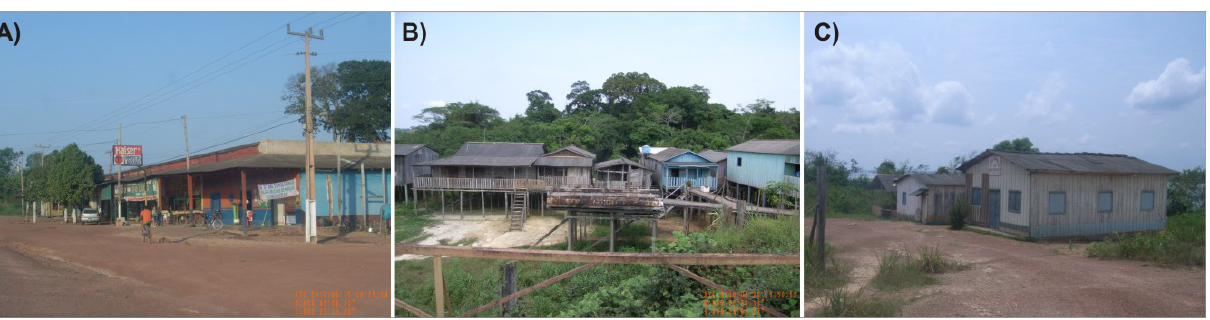
Figure 8. Spatial patterns verified within the units of human occupation categorized as Dependent on connectivity : ( A ) Taboca; ( B ) Aruri; ( C ) Nova